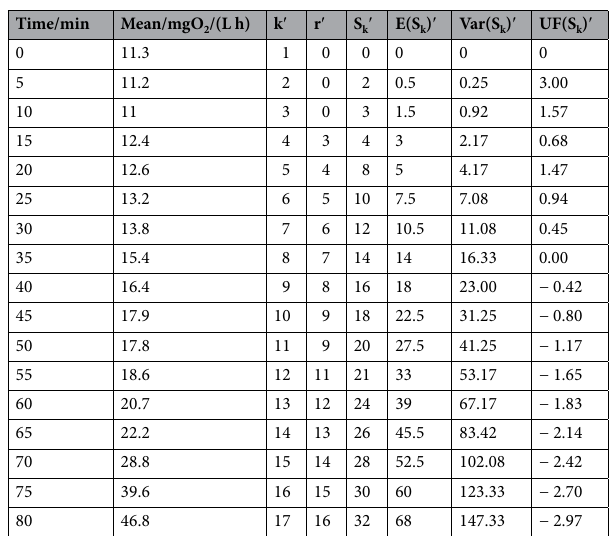
Table 4. Inverse sequence computation data of